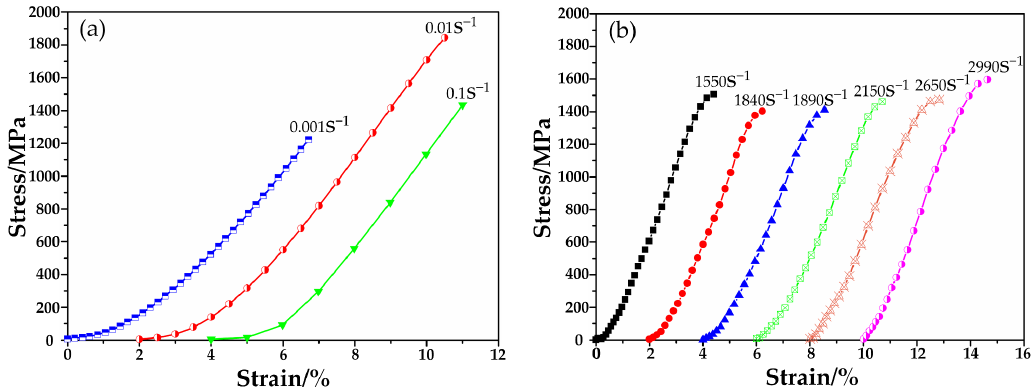
Figure 3. Stress − strain relations of specimens at different strain rates. ( a ) Quasi-static compressive tests and ( b ) dynamic compressive